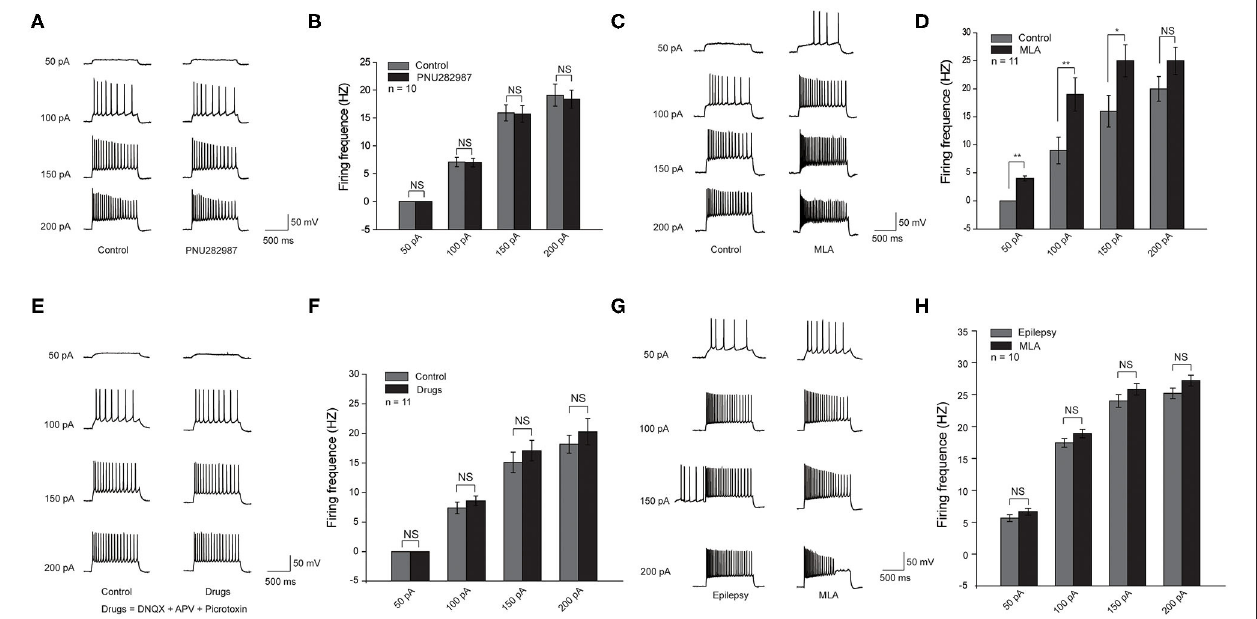
FIGURE 3 | Decreased activity of α 7 nAChRs could increase the excitability of the CA1 pyramidal neurons in the hippocampus in C57BL/6 wild-type mice. (A,C,E,G) Voltage responses of a representative to in pyramidal neurons to various injection steps (1s) from top to bottom, 50, 100, 150, 200pA. (A) Left: Control group. Right: PNU282987 group. (B) Summary histogram showing the number of pyramidal neuron APs. Two-way ANOVA was used. n = 10. (C) Left: Control group. Right: MLA group. (D) Summary histogram showing the number of pyramidal neuron APs. Two-way ANOVA was used. n = 11. (E) Left: Control group. Right: Drugs group (Drugs = DNQX + APV + Picrotoxin). (F) Summary histogram showing the number of pyramidal neuron APs. Two-way ANOVA was used. n = 11. (G) Left: Epilepsy group. Right: MLA group. (H) Summary histogram showing the number of pyramidal neuron APs. All pyramidal neuron membrane potential was kept at − 70mV by injecting